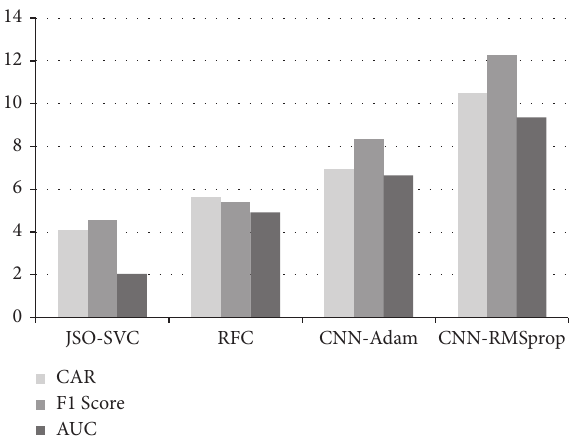
Figure 16: Model comparison in terms of the coefficient of variation